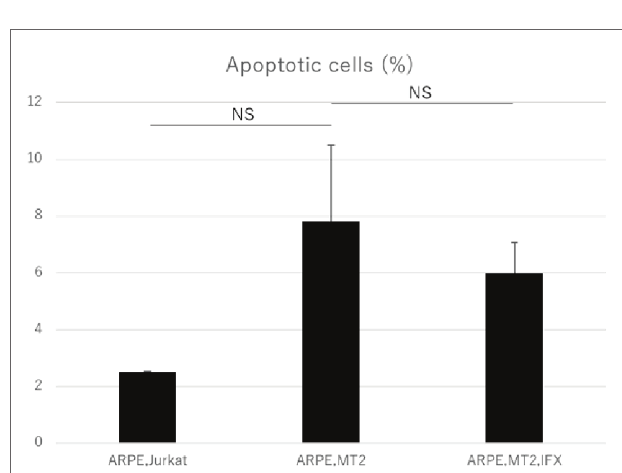
FIGURE 5 | Rate of apoptotic ARPE-19 cells in co-culture with Jurkat, MT2, and MT2 treated with IFX. No significant change in apoptotic rate of ARPE-19 is seen with IFX; rather, there is a slight decrease with IFX. Error bars represent standard deviations (NS, not